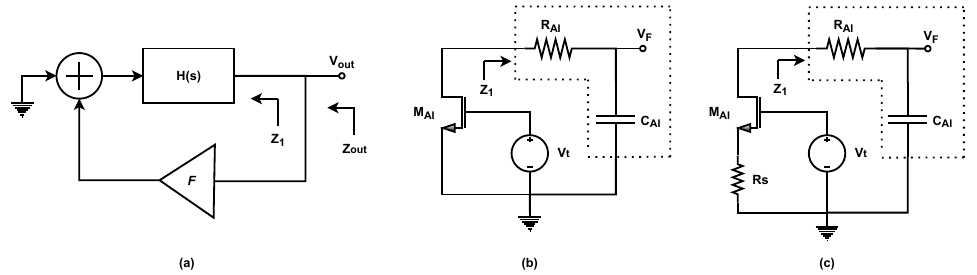
Figure A1. ( a ) Output impedance of a negative-feedback system. The open-loop circuit of ( b ) Figure 3a and ( c ) Figure